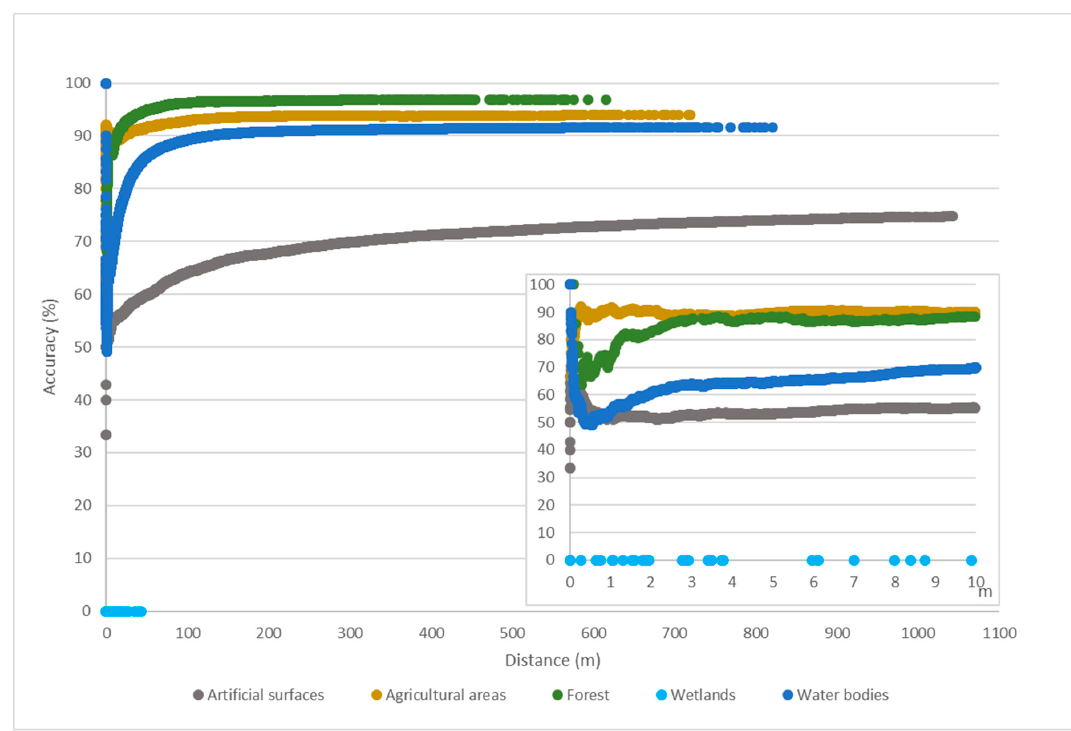
Figure 4. Overall relationship between training samples accuracy and feature boundary proximity. However, there was significant variability between the different LULC classes. Wetlands always presented 0% accuracy, as expected given the null thematic accuracy in 2015 described in Section 4.2., mainly due to the low total coverage (less than 0.001%). Forests, agricultural areas, and water had the